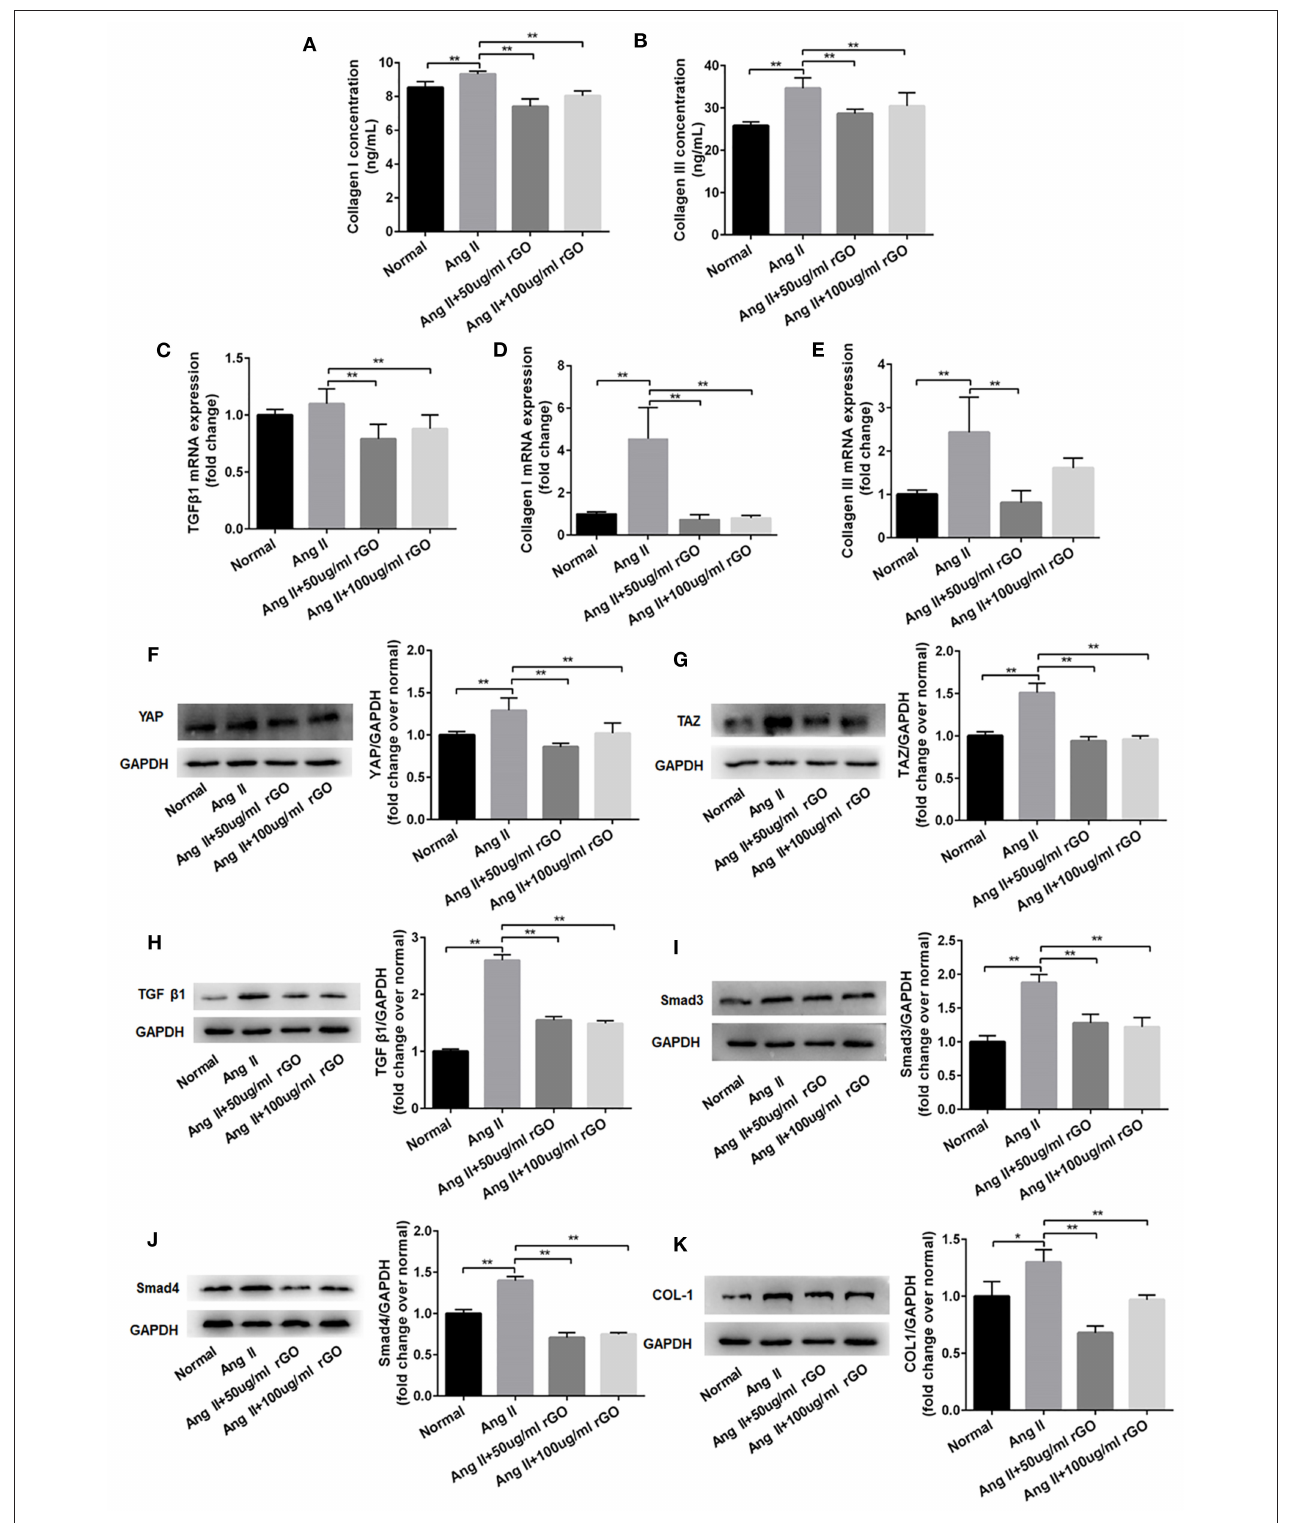
FIGURE 5 | rGO decreased the secretion of Col I and Co1 III in cardiofibroblasts (CFs) through Yap/Taz-TGF β 1/Smads signaling. (A,B) Effect of rGO on the secretion of Col I and Co1 III by CFs after angiotensin II (Ang II) treatment; CFs were treated with Ang II and rGO at 50 or 100 µ g/ml for 24h. (C–E) Effect of rGO on the mRNA expression of Col I, Co1 III and TGF- β 1. (F–K) Western blot analysis of the signaling pathway (YAP, TAZ, TGF-b1, Smad3, Smad4 and Col I) in CFs stimulated with Ang II and with rGO. Data are mean ± SEM from three independent experiments. * P < 0.05, ** P < 0.01.